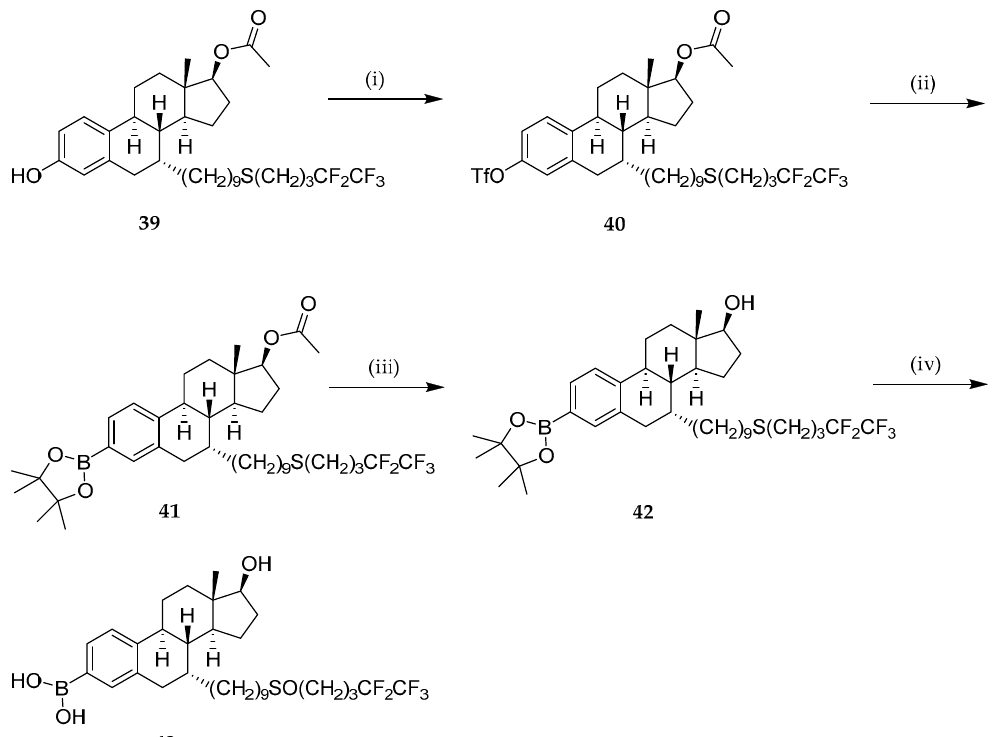
Table 4. Effects on growth inhibition (IC 50 , μ M ) of fulvestrant and compound 43 in different breast cancer cell lines.